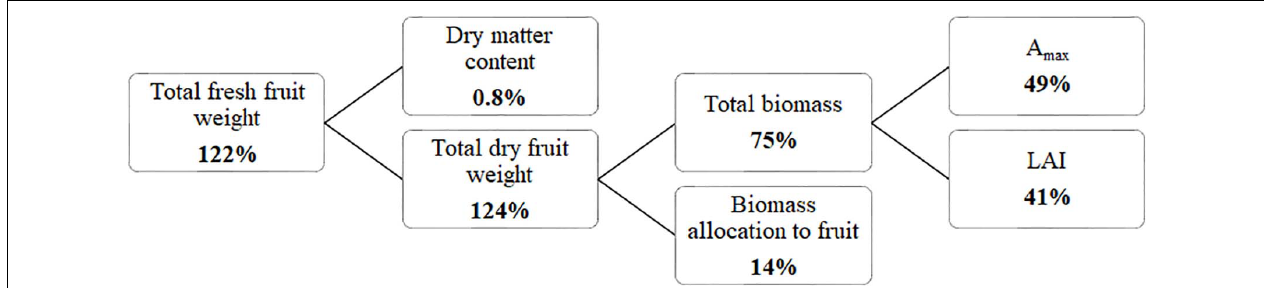
FIGURE 5 | Yield component analysis for a blackberry crop (spring crop cycle). Percentages indicate how much higher the component was for 185 µ mol m − 2 s − 1 ICL compared to no ICL. Yield (kg fresh fruit mass m − 2 ) = Total dry mass (kg plant dry mass m − 2 ) × Fraction to fruits (fruit dry mass/total dry mass)/fruit dry matter content (fruit dry mass/fruit fresh mass).